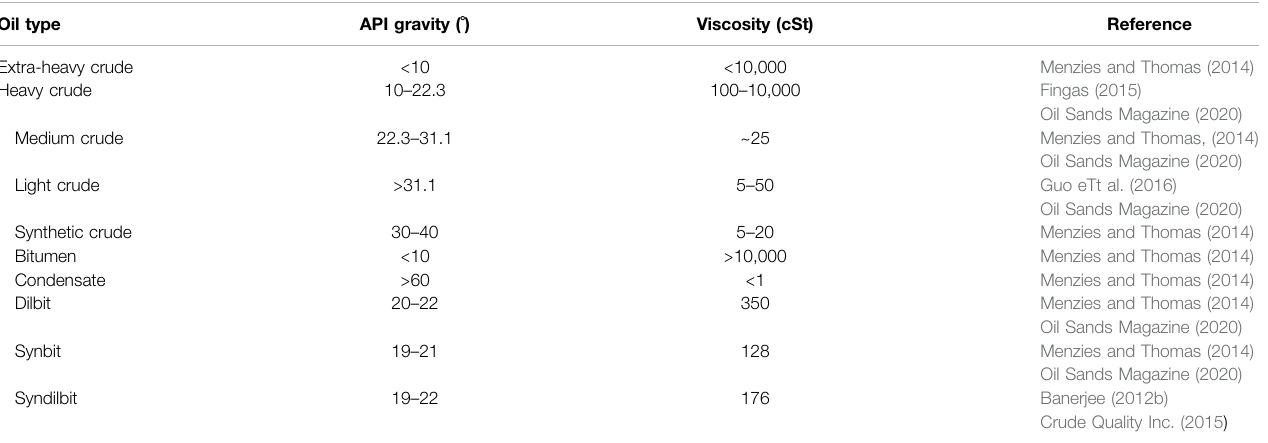
TABLE 2 | Physical properties of bitumen, diluted bitumen, and conventional